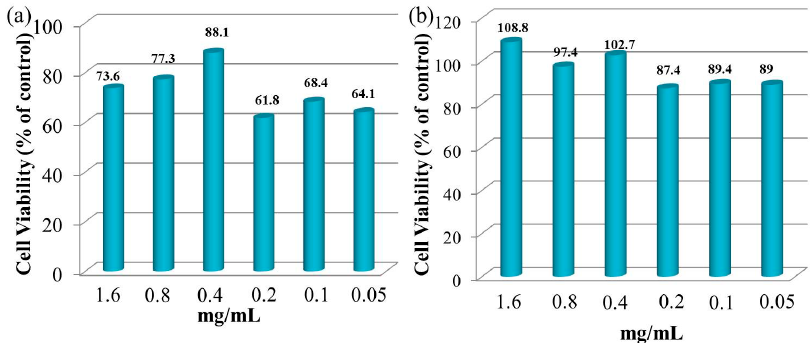
Figure 8. NIH3T3 cell viability of gel-3 under the different concentrations of 1.6–0.05 mg/mL after cultivating for 24 h and 72 h.